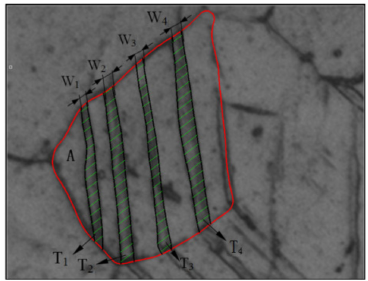
Figure 4. Schematic illustration of microstructural statistical variables.